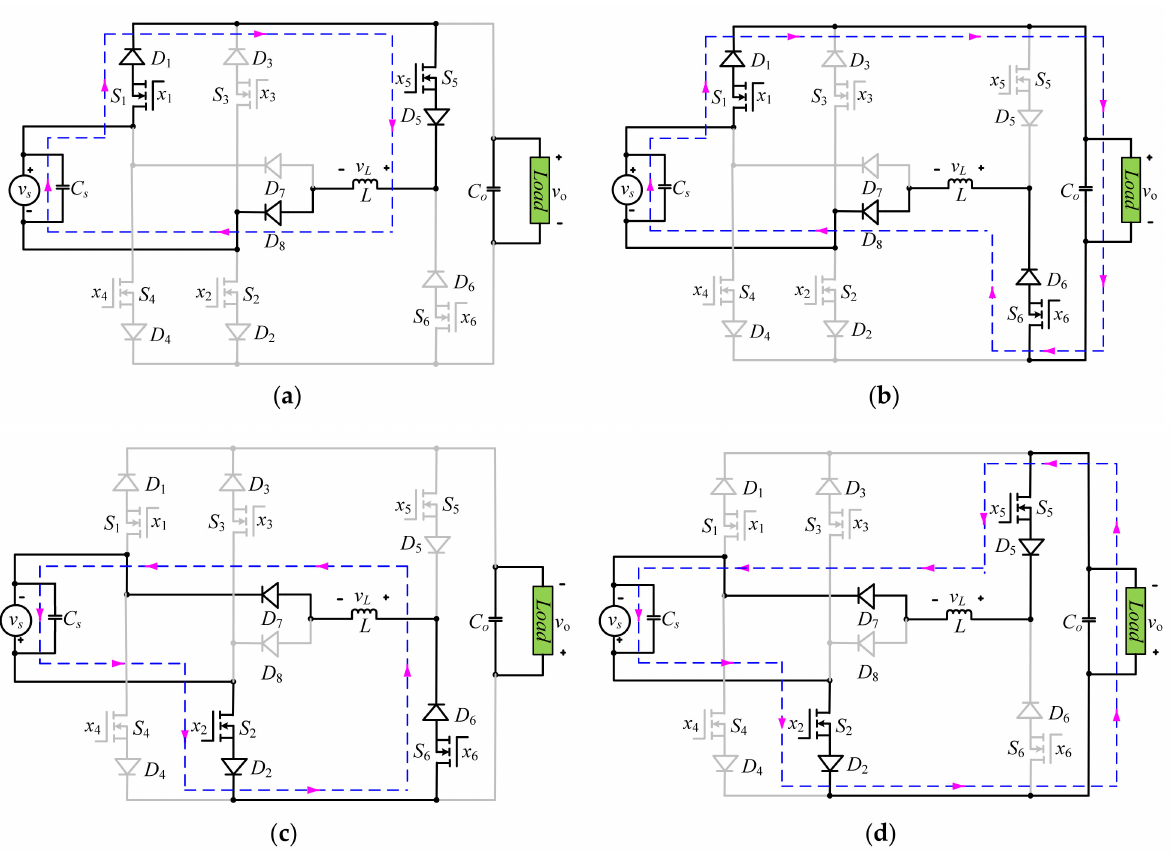
Figure 5. Equivalent current-conducting loops with respect to the input voltage to produce non- inverting boost operation during; ( a , b ) positive half cycles; ( c , d ) negative half